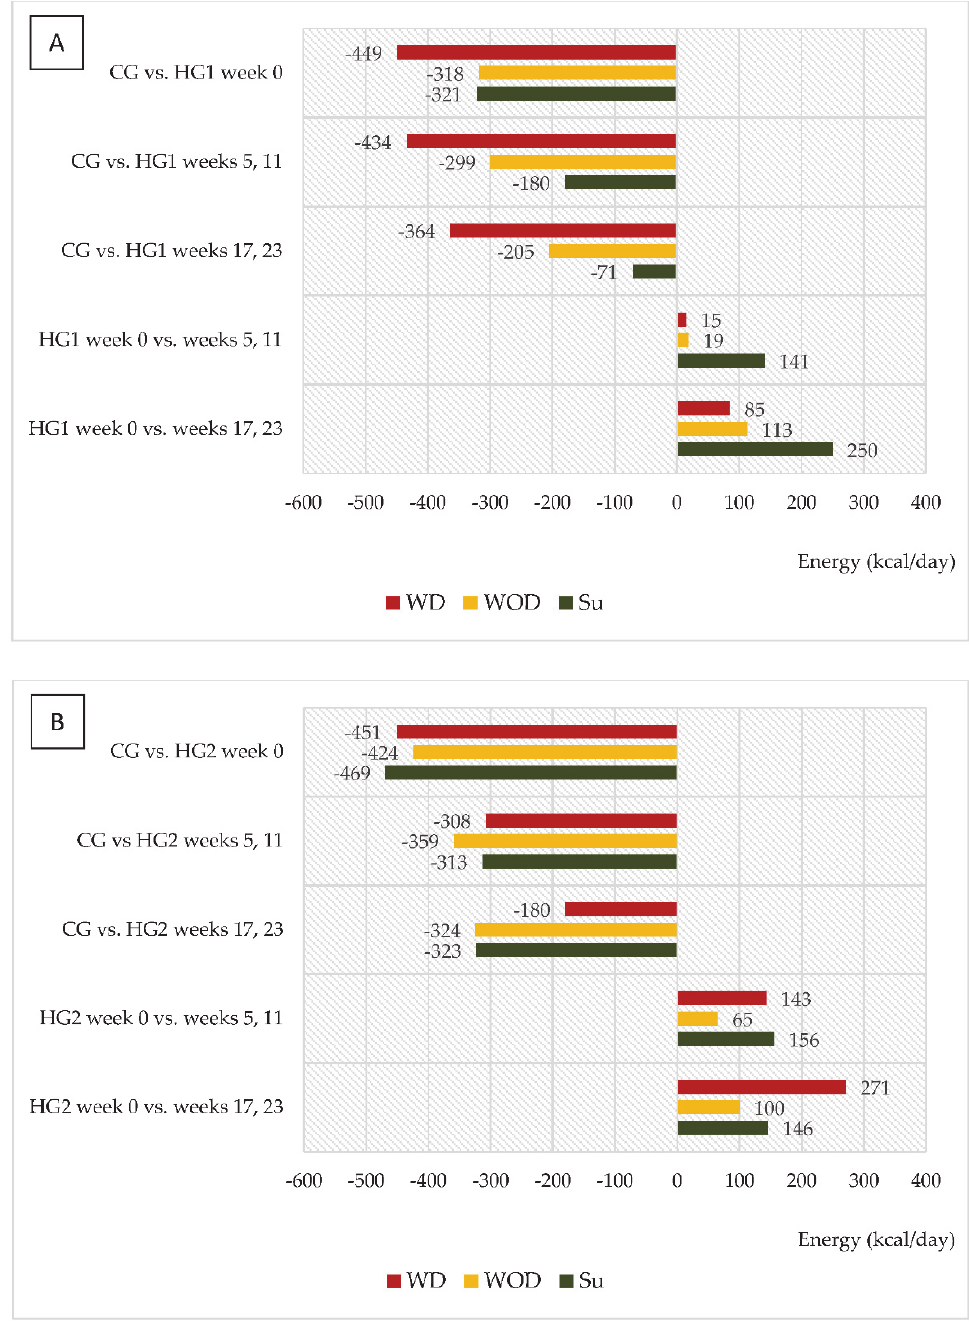
Figure 2. ( A , B ) Differences between daily energy intake (kcal/d) in comparison to the control group (CG) and in comparison to baseline values (week 0). ( A )—data regarding patients who were to comply with the dietary recommendations without a meal served before dialysis (HG1); ( B )—data regarding patients who were to comply with the dietary recommendations with a meal served before dialysis (HG2); WD—a day with dialysis; WOD—a day without dialysis; Su—Sunday.